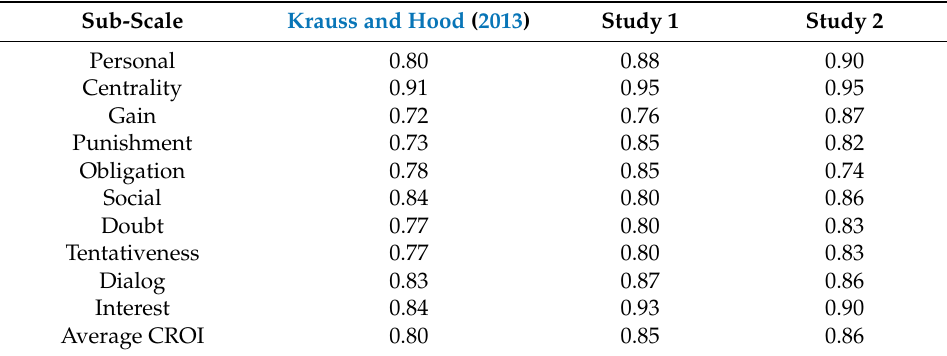
Table 3. Overall Internal Consistency of the